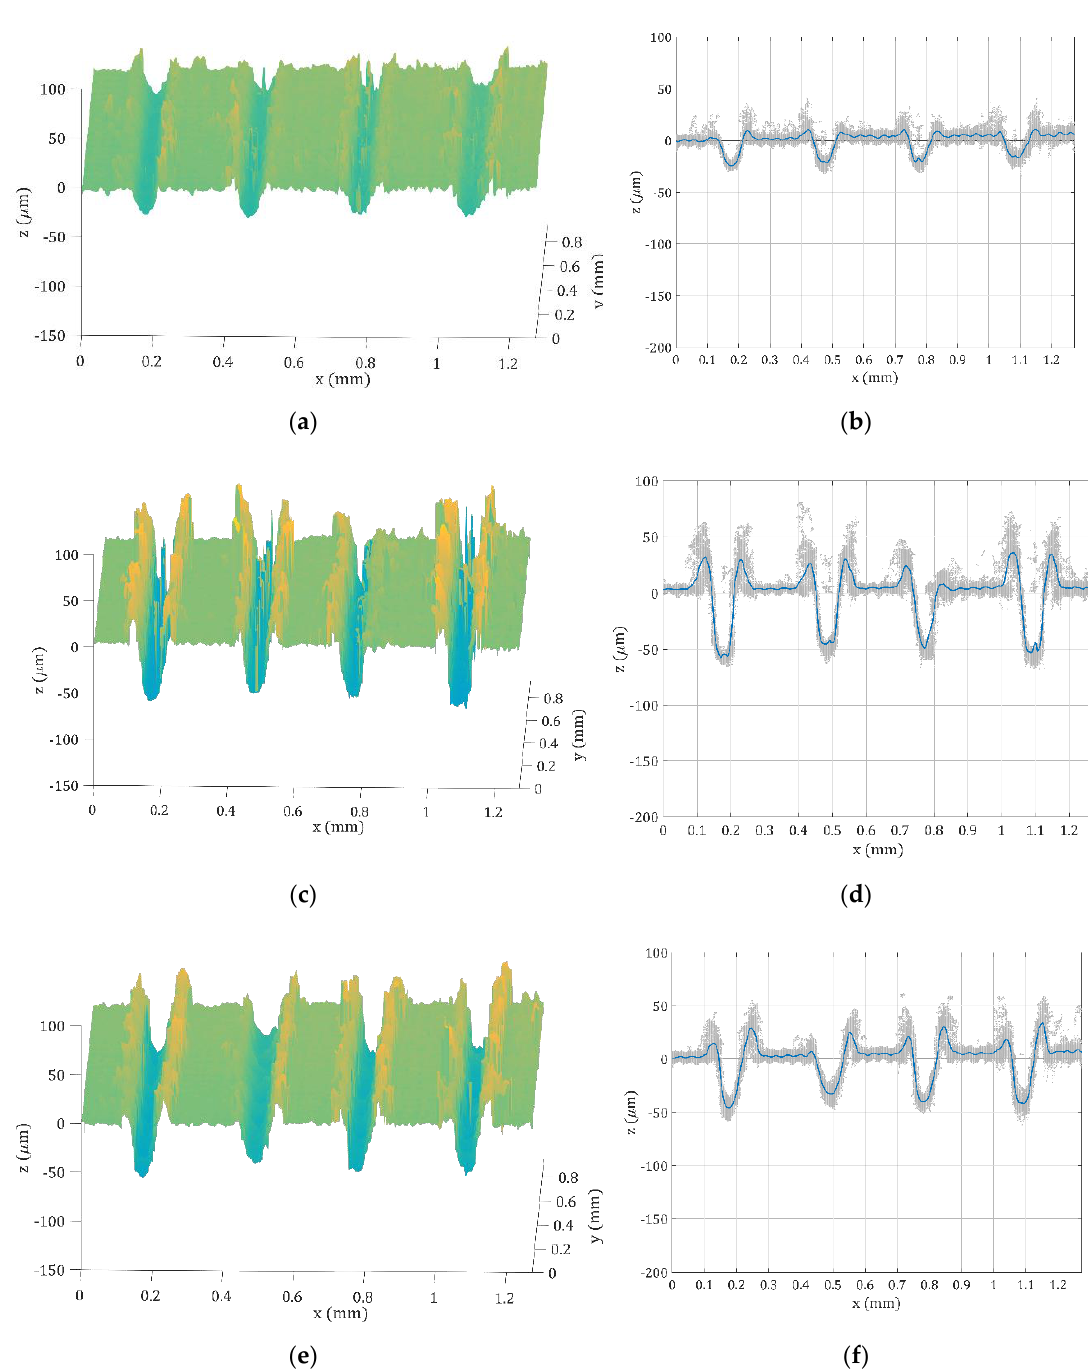
Figure 8. ( a ) The 3D topography at 30 kHz. ( b ) The extracted profiles at 30 kHz. ( c ) The 3D topography at 50 kHz. ( d ) The extracted profiles at 50 kHz. ( e ) The 3D topography at 70 kHz. ( f ) The extracted profiles at 70 kHz.